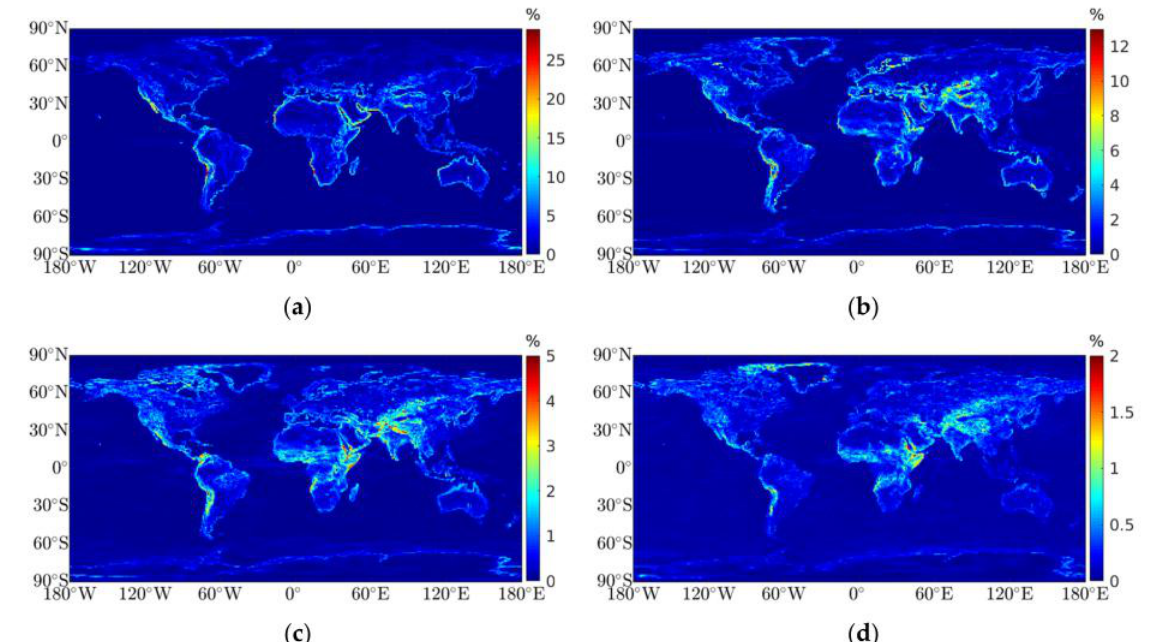
Figure 2. Maximum spatial variability for each relative humidity periodicity, calculated using a window of 4 × 4 grid points, approximately a 1 ◦ × 1 ◦ horizontal grid: ( a ) mean values (%); ( b ) annual amplitude (%); ( c ) semi-annual amplitude (%); ( d ) quarterly amplitude (%).